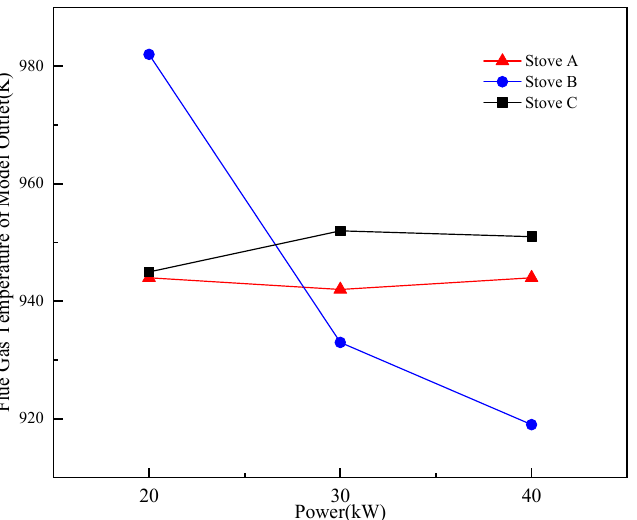
Figure 13. CO mass fraction contours of the central section of the three stoves at 40 kW: ( a ) staple